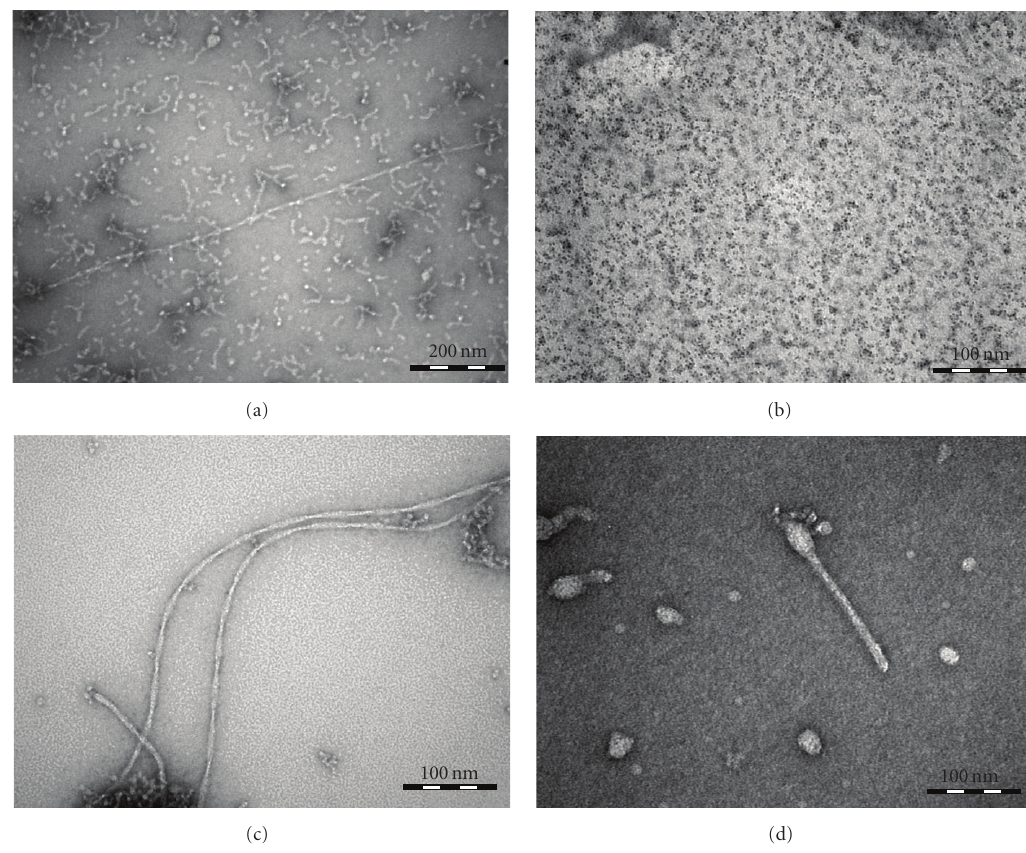
Figure 4: TEM images: (a) A β (1–42) in PBS bu ff er (pH 7.4); (b) DHLA-capped QDs; (c) A β (1–42) mixed with DHLA-capped QDs in PBS bu ff er (pH 7.4); (d) A β (1–42) conjugated to DHLA-capped QDs in PBS bu ff er (pH